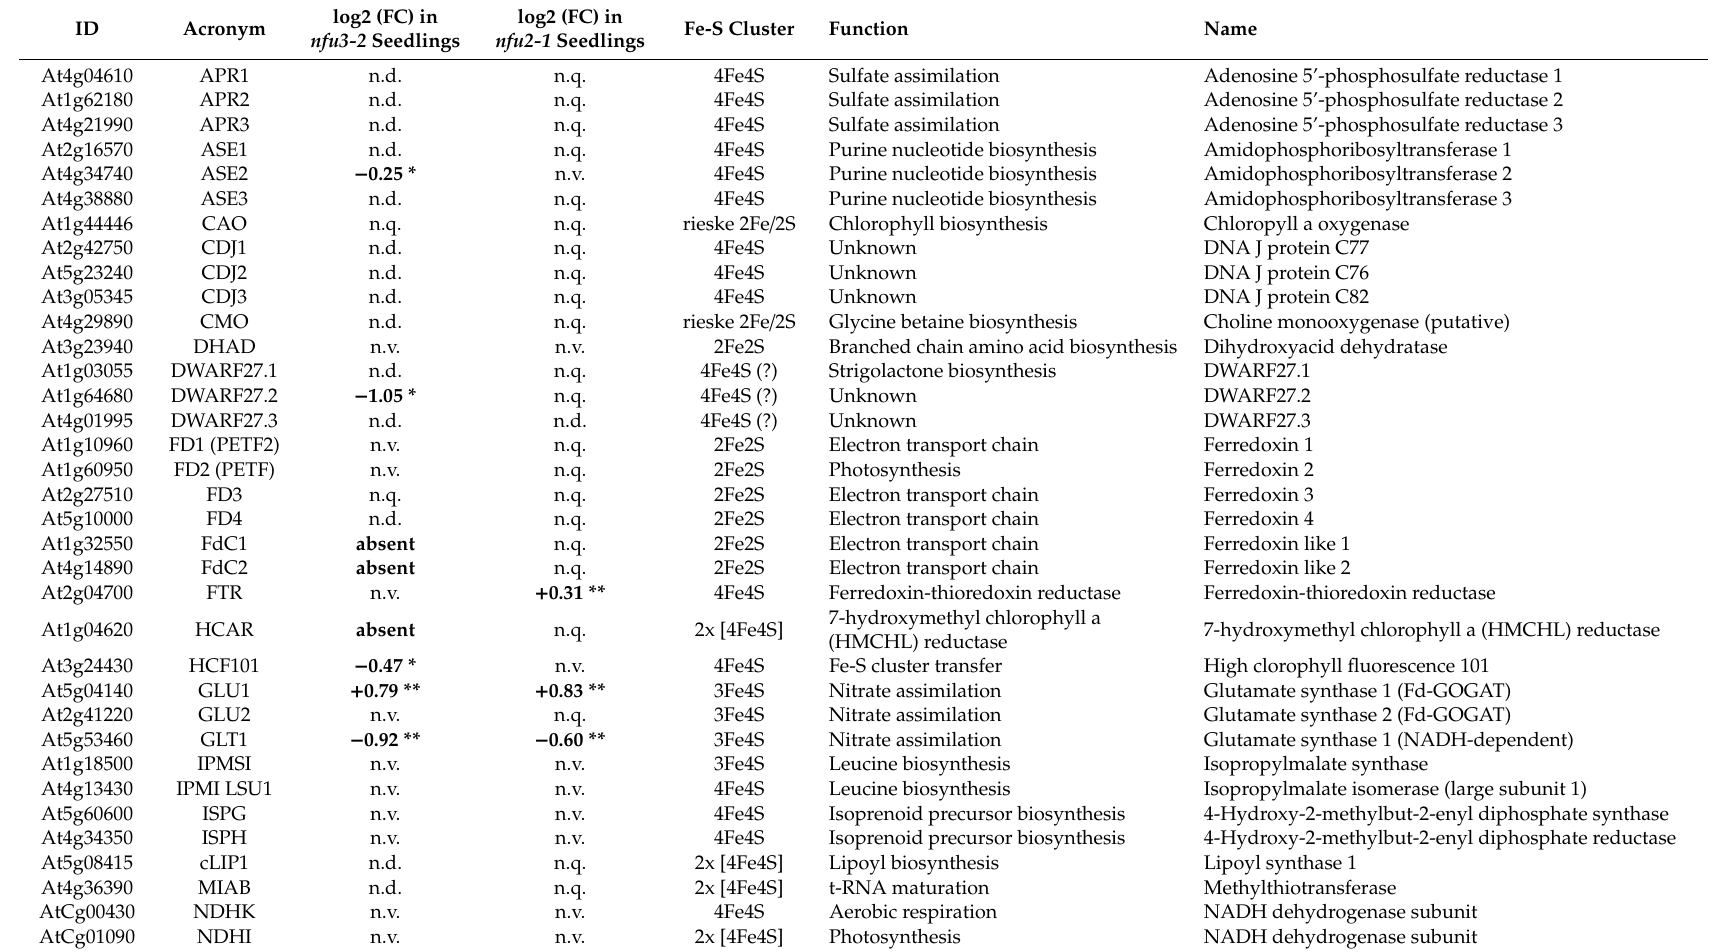
Table 2. Quantification of Fe-S proteins in the Arabidopsis thaliana nfu3-2 mutant